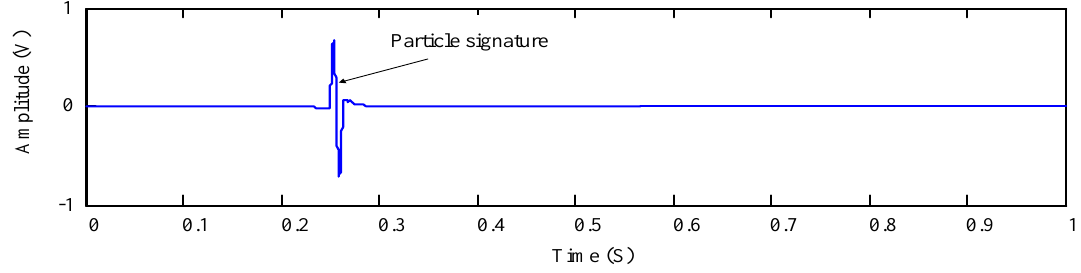
Figure 6. The extracted particle signature reconstructed from the shrunk coefficients as shown in Figure